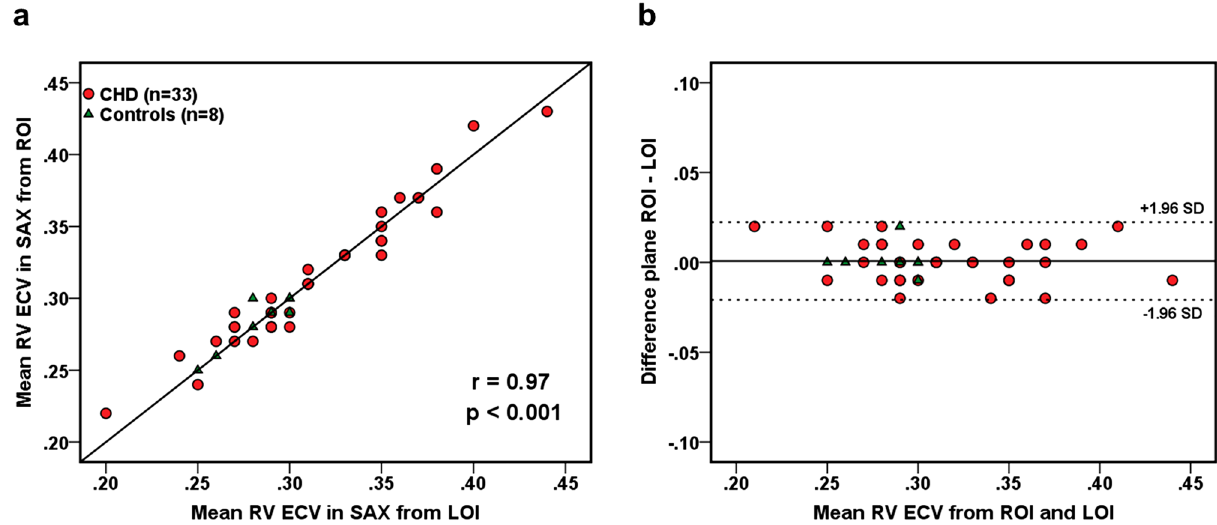
Figure 4. Extracellular volume—region of interest versus line of interest. Correlation ( a ) and Bland–Altman analysis ( b ) of right ventricular myocardial extracellular volume (RV ECV) from regions of interest (ROIs) and corresponding lines of interest (LOIs) in short axis orientation across healthy controls and patients with congenital heart disease. Controls Patients SAX TRANS